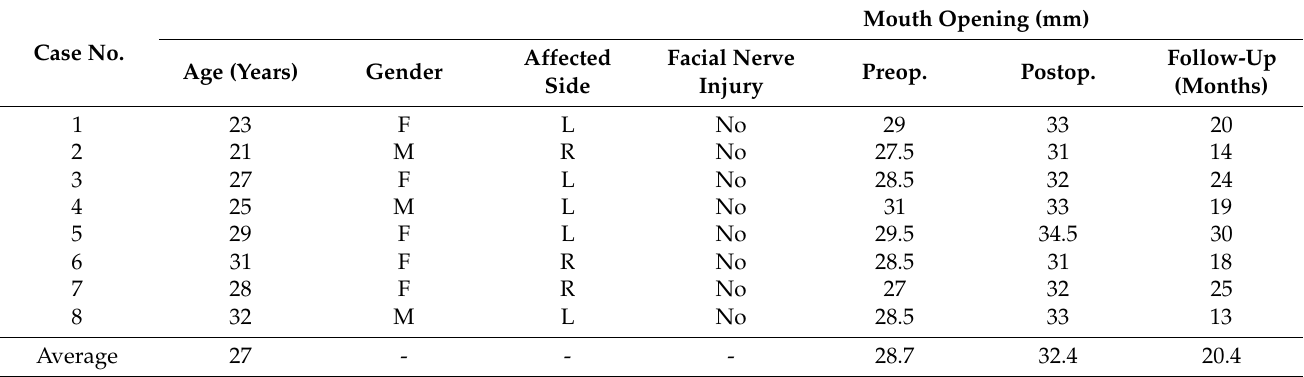
Table 2. Patient characteristics.